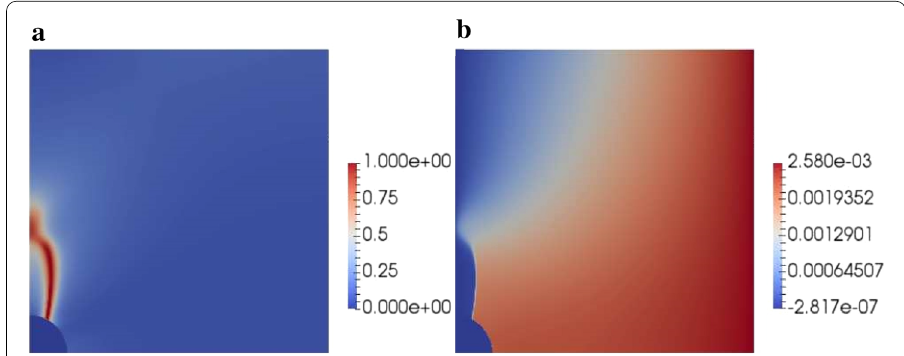
Fig. 20 Micromechanics of fibre reinforced composite materials: a final damage pattern. b Final horizontal